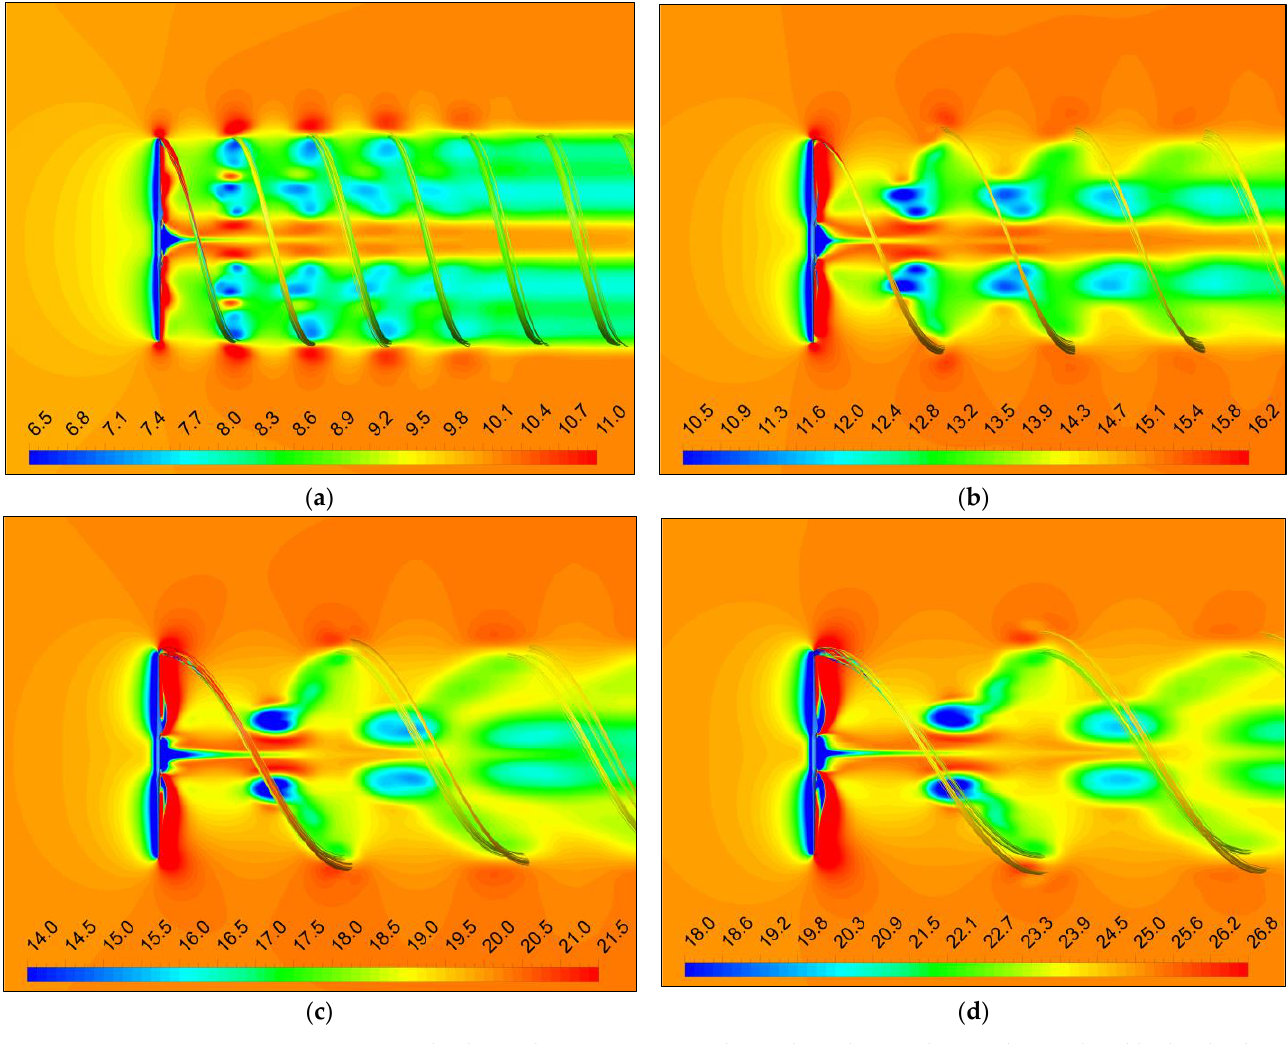
Figure 9. Absolute velocity contours on the median plane and streamlines colored by local velocity: ( a ) wind speed, 10 m/s; ( b ) wind speed, 15 m/s; ( c ) wind speed, 20 m/s; ( d ) wind speed, 25 m/s. All color scales are in m/s and the ranges are correlated to wind speed.